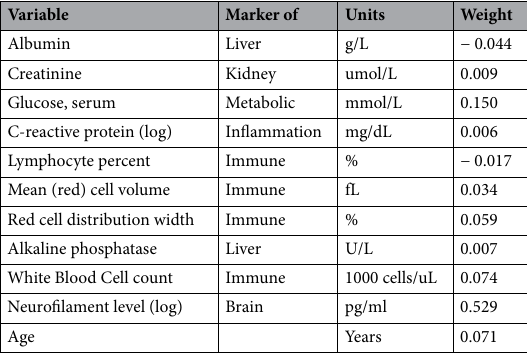
Table 3. Gompertz coefficients developed in the Rotterdam study for BioAge2: with brain marker NfL.